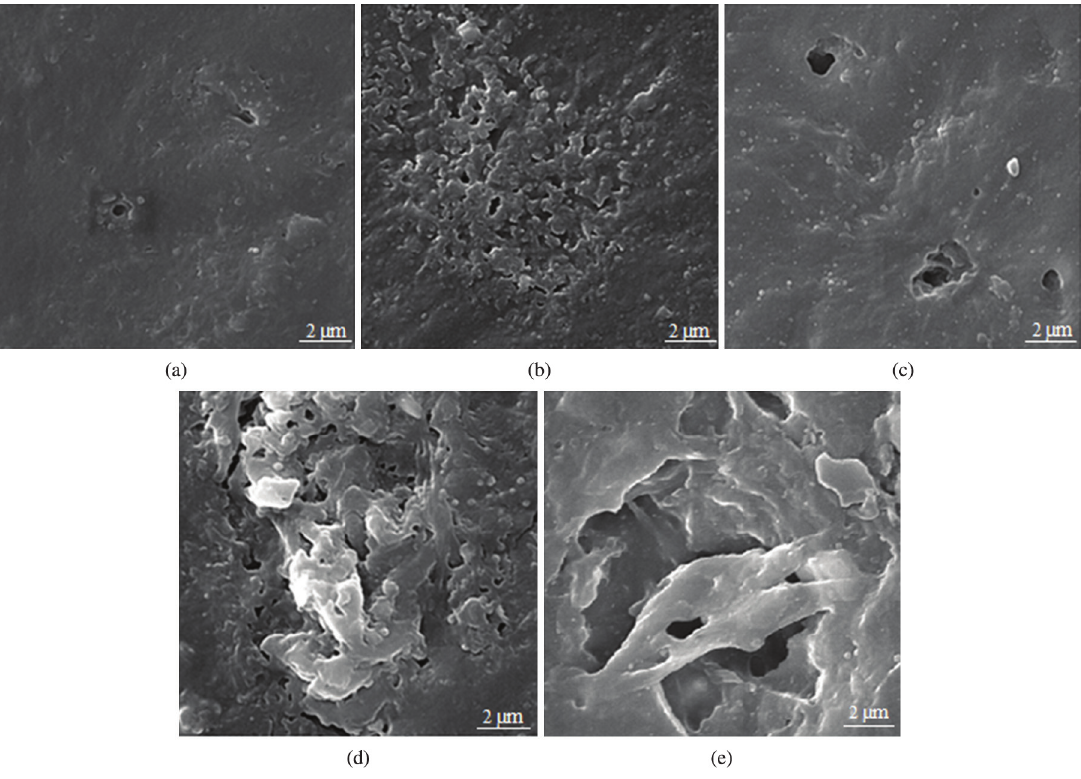
Figure 6. SEM images of nano-composite samples after 500 hours UV radiation: (a) pure PP, (b) PP5Ti, (c) PP10Ti, (d) PP30Ti and (e)